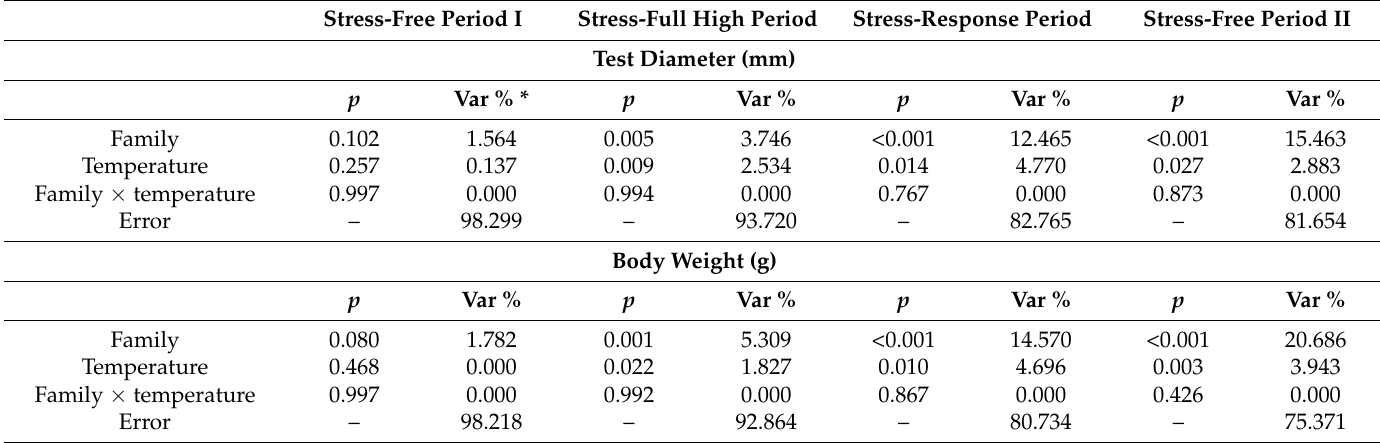
* Var % represents the proportions of total phenotypic variation explained by each